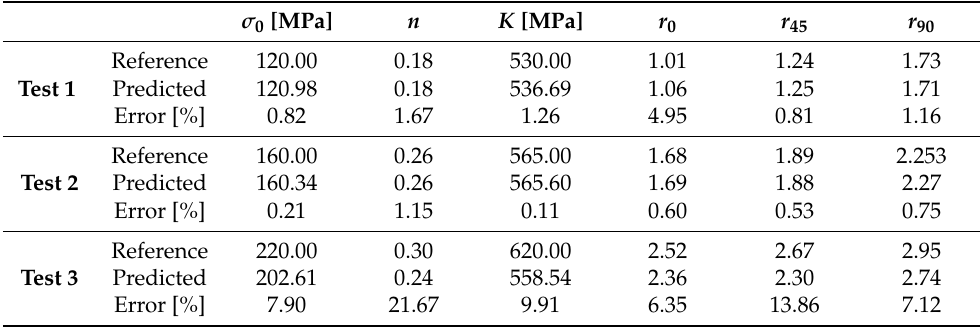
Table 4. Predictions and corresponding errors for inverse cruciform test model.